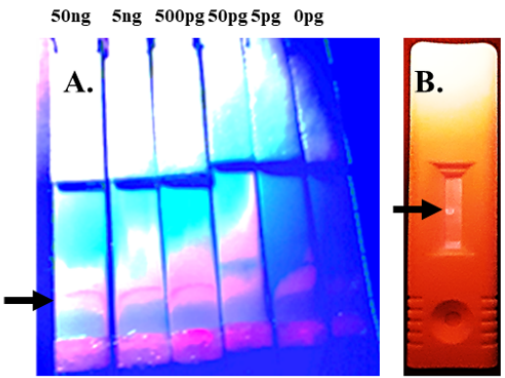
Figure 4. Panel ( A ) illustrates the appearance of a Clonorchis Cs44 titration on lateral flow test strips using an aptamer–biotin–streptavidin–red Qdot 655 conjugate that migrated out of the conjugate pads near the bottom of the photograph to bind dried recombinant Cs44 protein lines at the levels indicated above the panel (i.e., 50 ng to 5 pg) with a detection limit of at least 5 pg versus the blank control as indicated by the capture lines shown at the arrow level. Panel ( B ) shows a similar preliminary capture test for 50 ng of the C. sinensis recombinant egg protein dried as a dot on the analytical membrane after interaction with an aptamer–biotin–streptavidin–Qdot 655 conjugate to provide